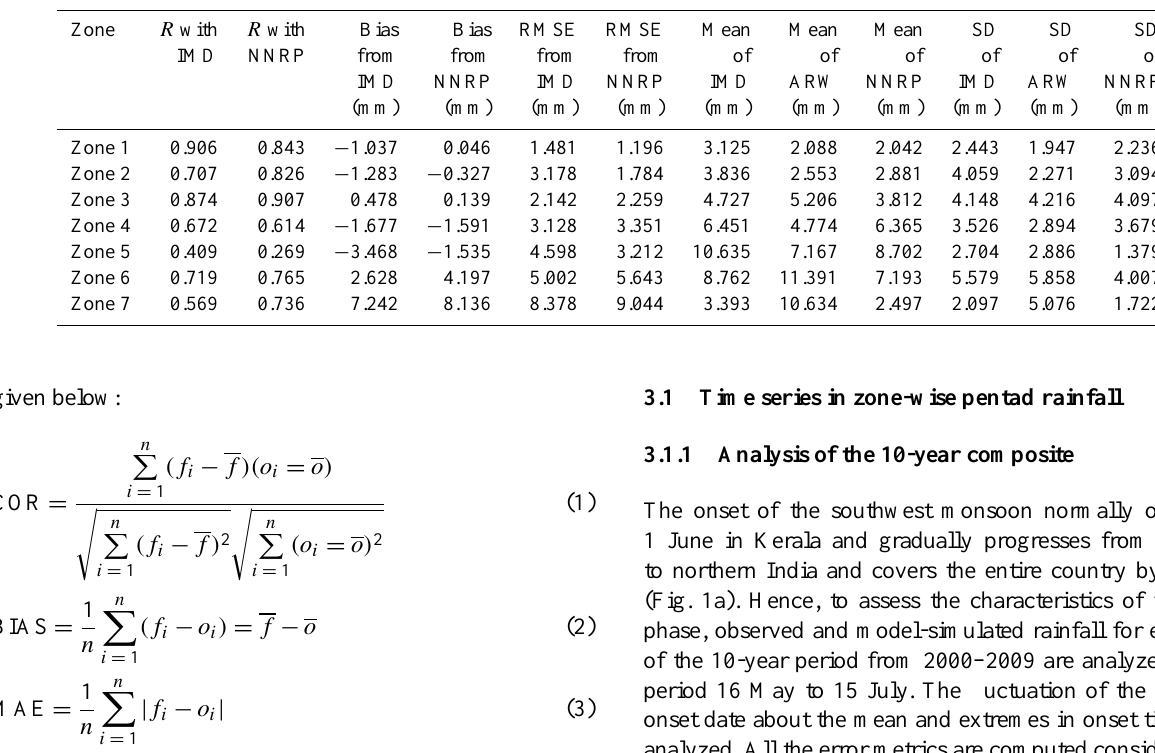
Table 1. Error metrics (correlation – R , standard deviation (SD), bias and root mean square error (RMSE)) between simulated, NNRP precipitation and IMD observed daily rainfall time series from 16 May to 15 July for different zones for the composite